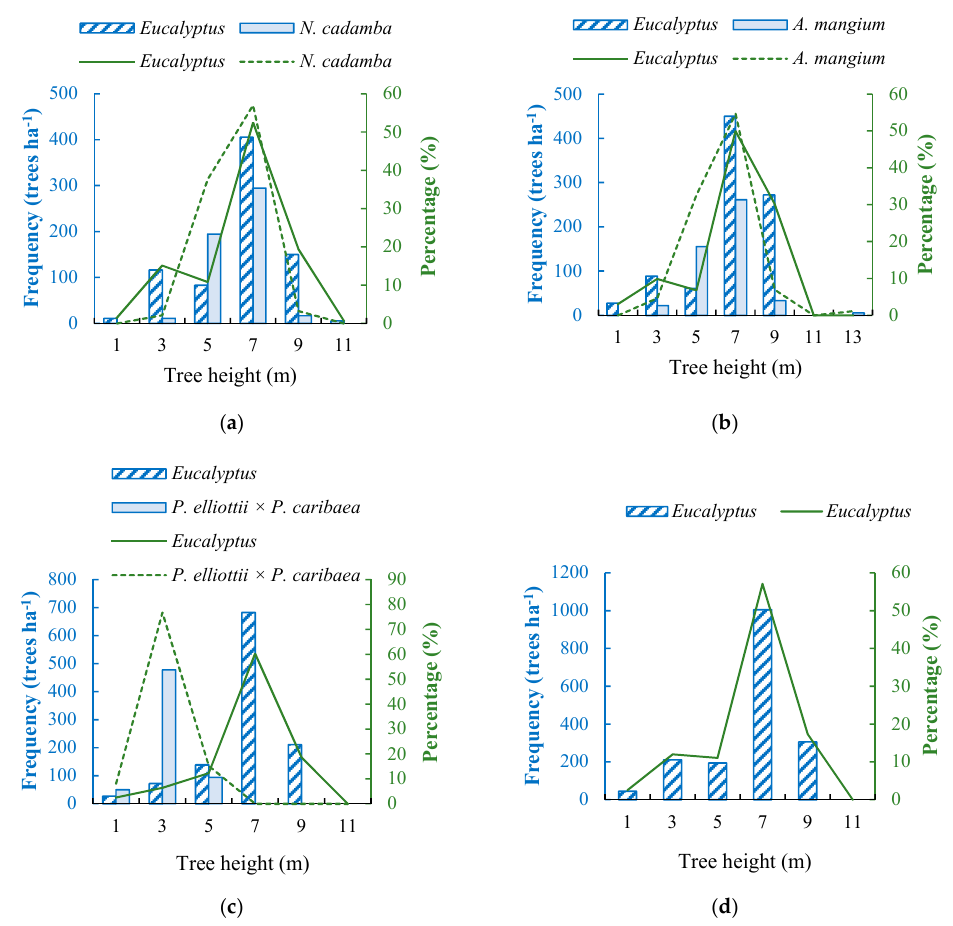
Figure 4. Tree height distribution of E. urophylla × E. grandis at the age of 18 months and of mixed tree species at the age of 38 months in the monoculture and mixtures. Height of the histograms shows the distribution frequency of tree height of each tree species per hectare. The line shows the distribution percentage of tree height of each tree species per hectare. ( a ) Mixed plantation of Eucalyptus and N. cadamba (EN); ( b ) mixed plantation of Eucalyptus and A. mangium (EA); ( c ) mixed plantation of Eucalyptus and P. elliottii × P. caribaea (EP); ( d ) pure forest of E. urophylla × E. grandis (EE).